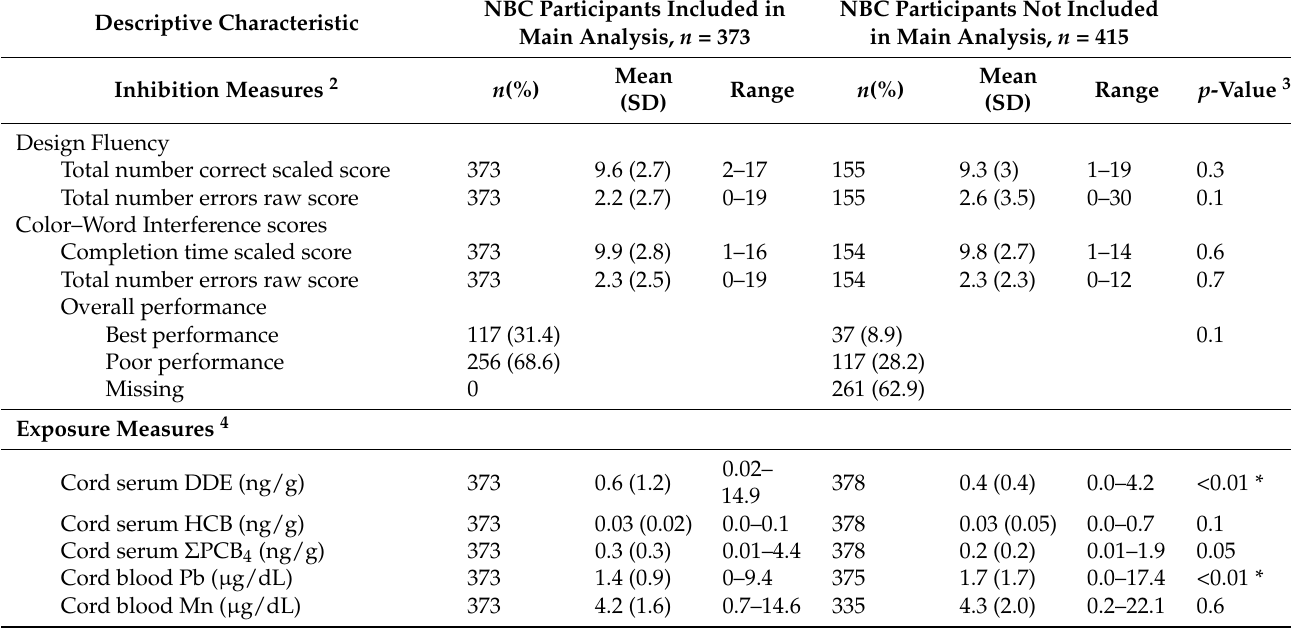
Table 1. Characteristics of New Bedford Cohort participants who were included in the main analysis group 1 and those who were not included in the main